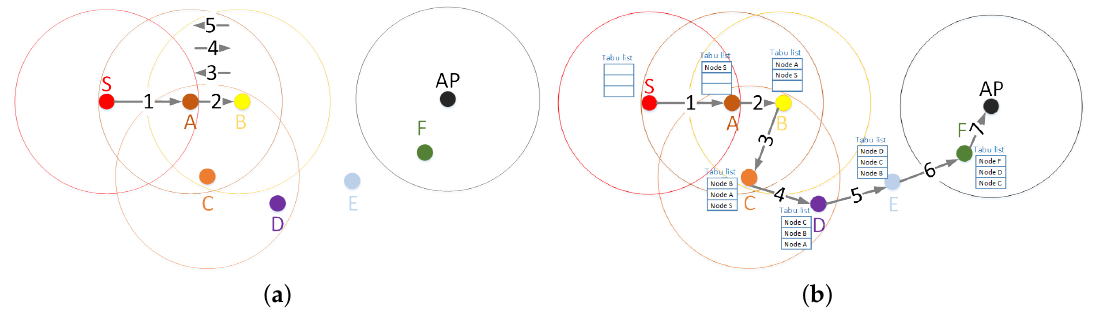
Figure 1. An example that shows how Tabu avoids loops and improves the operation of a basic routing protocol based on forwarding the packet to the closest neighbor to destination. ( a ) Forwarding to the closest neighbor fails when two nodes are both the closest neighbors to destination, as Nodes A and B in this topology; ( b ) Tabu breaks the loop between Nodes A and B. Tabu list prevents B from returning the packet to A. Node C receives the packet from